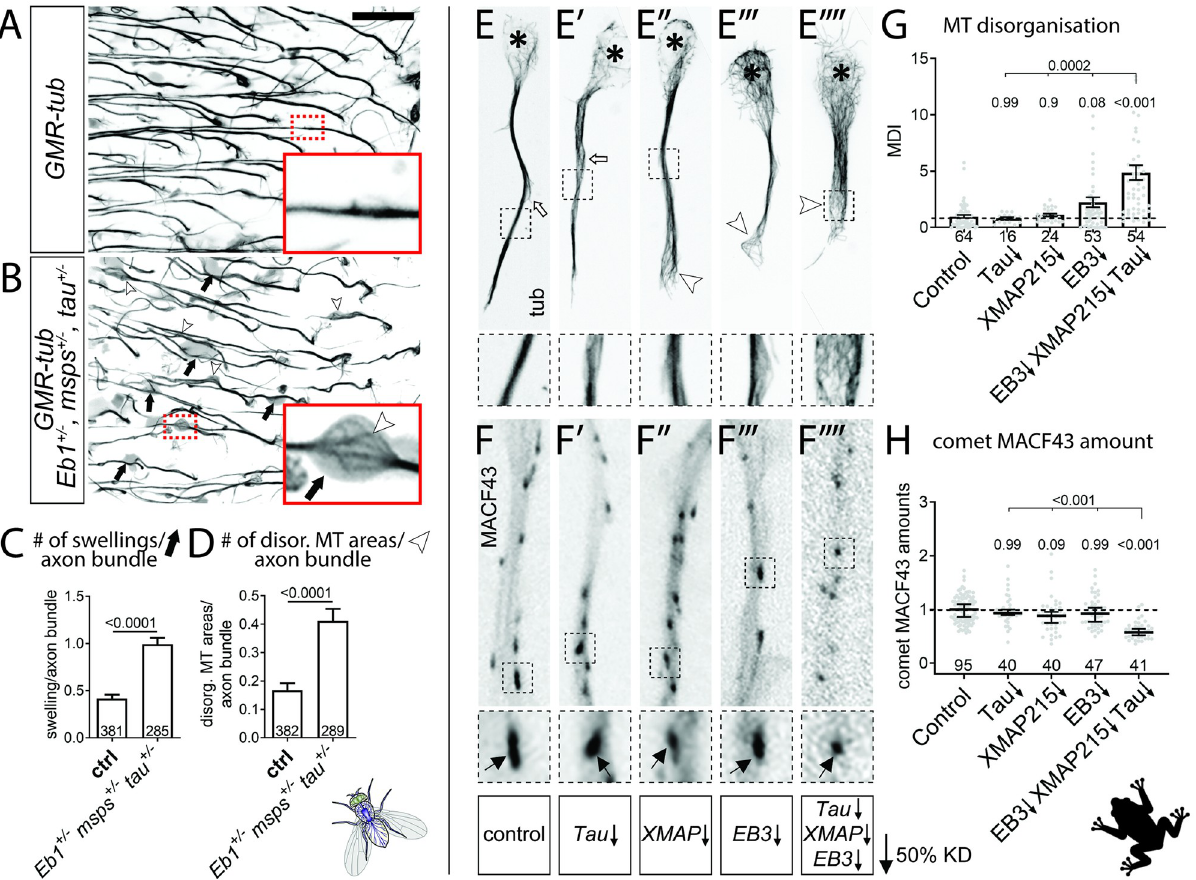
Fig 3. Eb1, Msps and Tau functionally interact in the fly brain and in frog primary neurons. A,B ) Medulla region of adult brains at 26–27 days after eclosure, all carrying the GMR31F10-Gal4 driver and UAS-GFP- α -tubulin84B ( GMR-tub ) which together stain MTs in a subset of lamina neuron axons that terminate in the medulla; the further genetic background is either wild-type (A) or triple-heterozygous ( Eb1 04524/+ msps A/+ tau KO/KO ; B); white/ black arrows indicate axonal swellings without/with MT curling; rectangles outlined by red dashed lines are shown as 2.5 fold magnified insets where white arrow heads point at disorganised curling MTs. C,D ) Quantitative analyses of specimens shown in A and B: relative number of total swellings per axon (C) and of swellings with MT curling per axon (D); bars show mean ± SEM; P values from Kruskal–Wallis one-way tests are given above each column, merged sample numbers (i.e. individual axon bundles) from at least two experimental repeats at the bottom of each bar. E-E”” ) Primary Xenopus neurons stained for tubulin (tub): asterisks indicate cell bodies, white arrows indicate unbundled MTs, white arrowheads unbundled areas with MT curling. F-F”’ ) Xenopus neurons labelled with MACF43::GFP (MACF43): black arrows point at comets (visible as black dots). In E-F”’, black- stippled squares in overview images are shown as 2.5 fold magnified close-ups below; # behind gene symbols indicates 50% knock-down thus approximating heterozygous conditions. G,H ) Quantification of specimens shown in E-F””with respect to MT curling (G) and comet amount of MACF43::GFP (H); data were normalised to parallel controls (dashed horizontal lines) and are shown as mean ± SEM (G) or median ± 95% confidence interval (H); merged sample numbers from at least two experimental repeats are shown at the bottom, P-values obtained with Kruskall-Wallis ANOVA tests above data points/bars. The scale bar in A represents 15 μ m in A,B and 20 μ m in E-F””. For raw data see S3